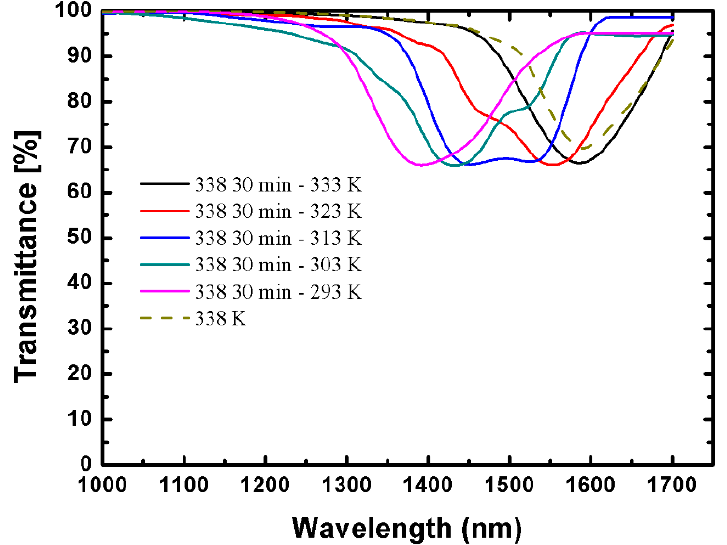
Figure 4. Transmission spectra of the PSCLC filter with a holding treatment for 30 minutes at 338 K and polymerization at different temperatures.